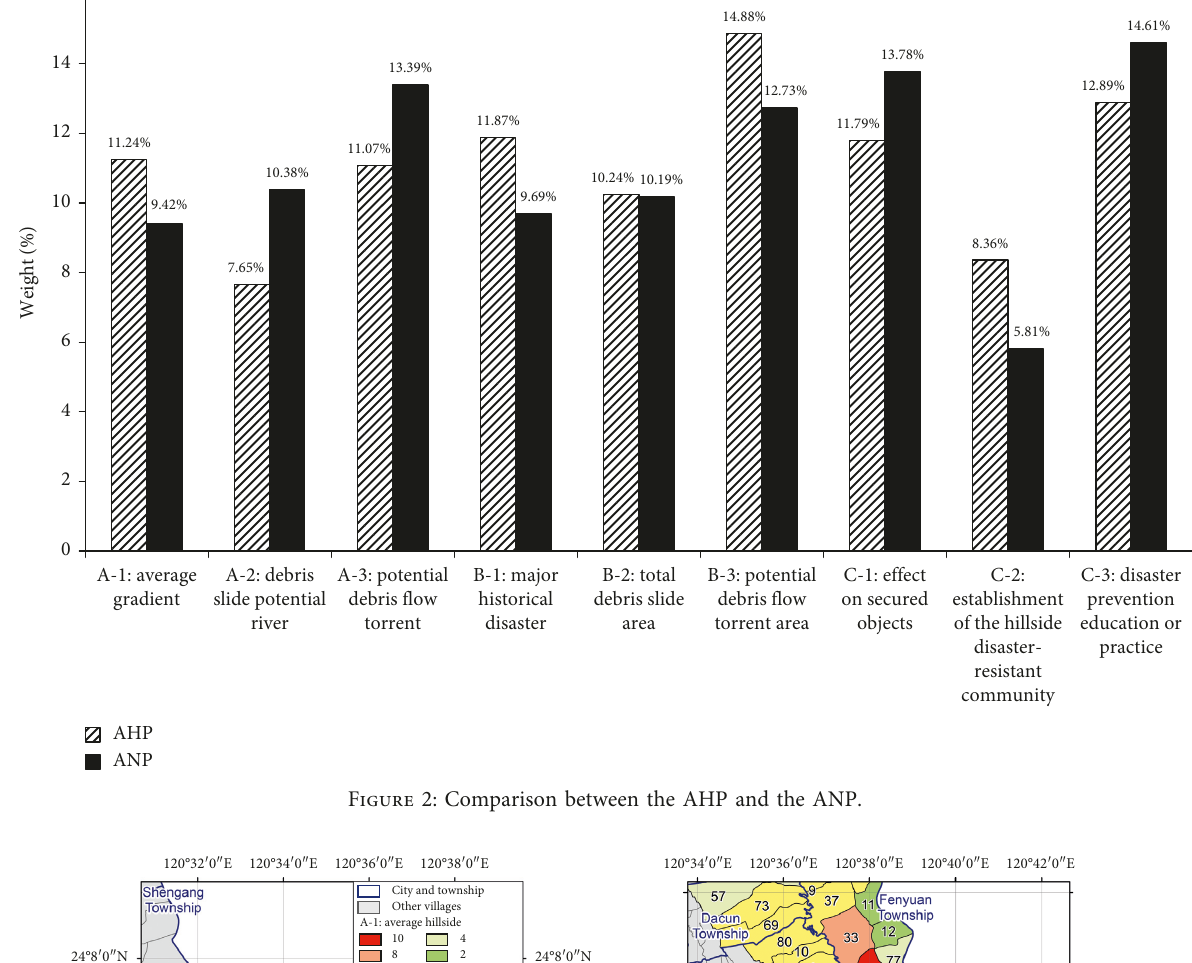
Figure 2: Comparison between the AHP and the ANP.